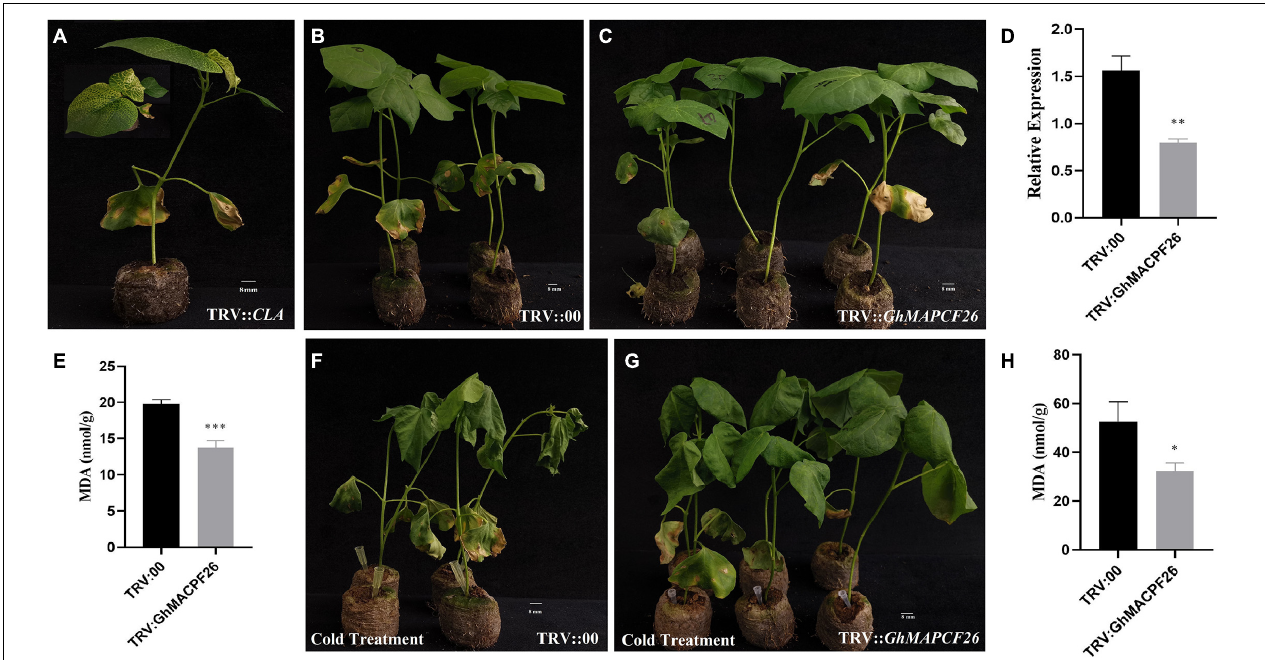
FIGURE 7 | Silencing GhMACPF26 via virus-induced gene silencing (VIGS) enhances the cold resistance regulation of cotton. (A) Plant albino phenotypes of TRV:: CLA . (B,C) Phenotypes of TRV::00 and TRV:: GhMACPF26 before cold stress. (D) GhMACPF26 expression levels in leaves of TRV::00 and TRV:: GhMACPF26 plants. (E) The malondialdehyde (MDA) content of TRV::00 and TRV:: GhMACPF26 before cold stress. (F,G) Phenotypes of TRV::00 and TRV:: GhMACPF26 after cold treatment for 24 h. (H) The MDA content of TRV::00 and TRV:: GhMACPF26 after cold stress. * p < 0.05, ** p < 0.01, and *** p < 0.001 (Student’s one-tailed t